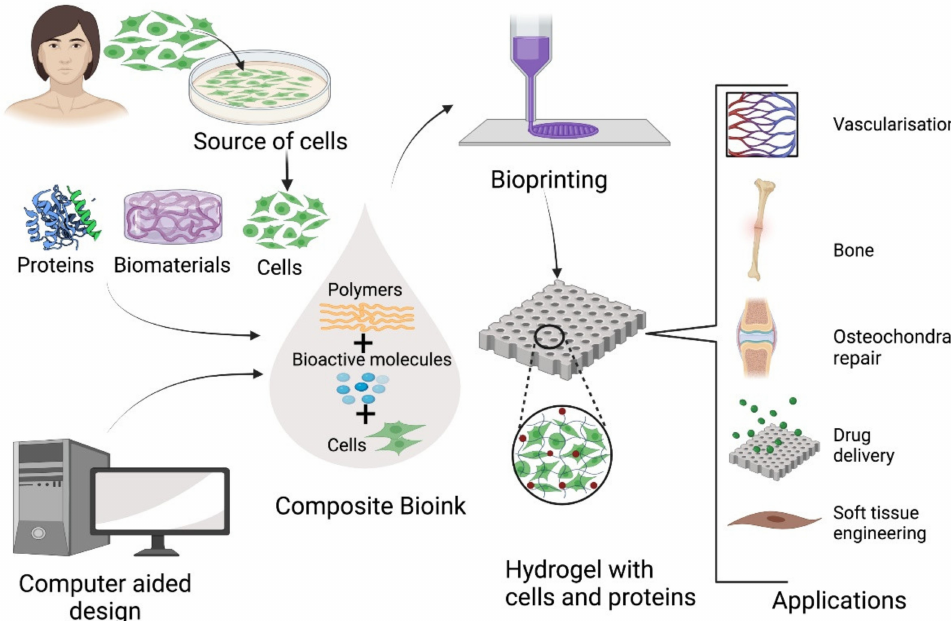
Figure 2. Bioprinting of natural polymers, frequently in combination with cells and/or biomolecules to fine-tune or increase in vivo activity, has potential to provide carefully designed, highly structured materials for tissue and organ engineering